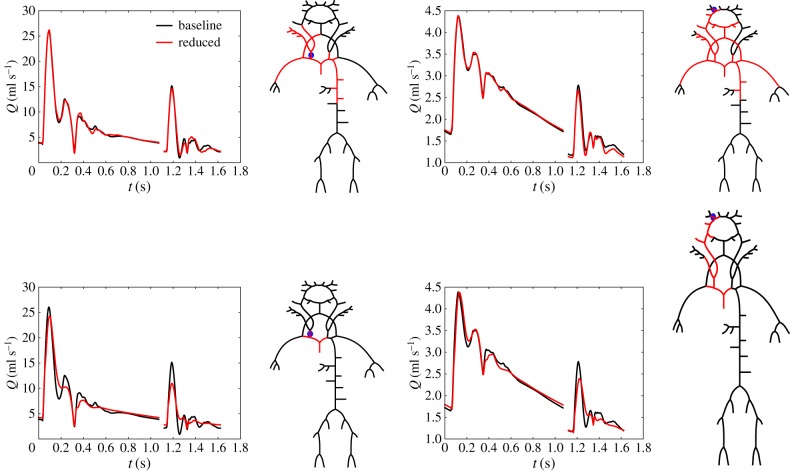
Optimal reduced networks for flow at the distal end of the right carotid artery (left panel) and proximal end of the right middle cerebral artery (right panel). The networks are the same as shown in figure 6; however, results are shown for two different inlet waveforms as described in §2.6.